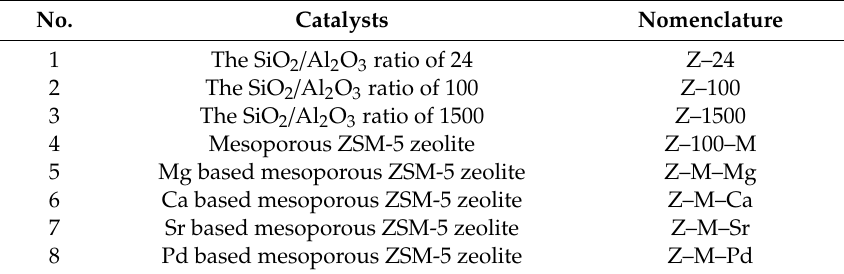
Table 7. Di ff erent ZSM-5 zeolite